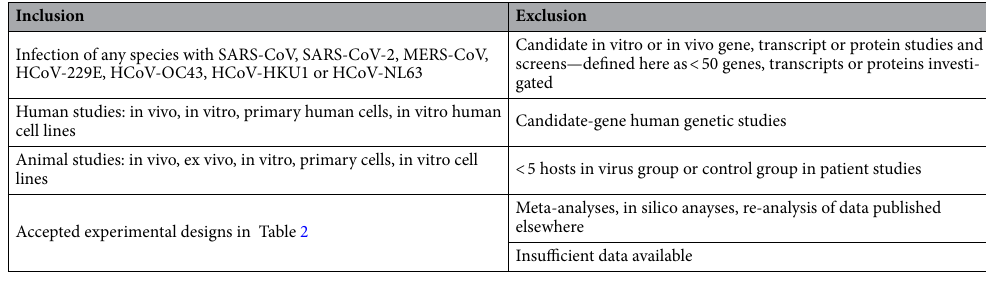
Table 1. Entry criteria.